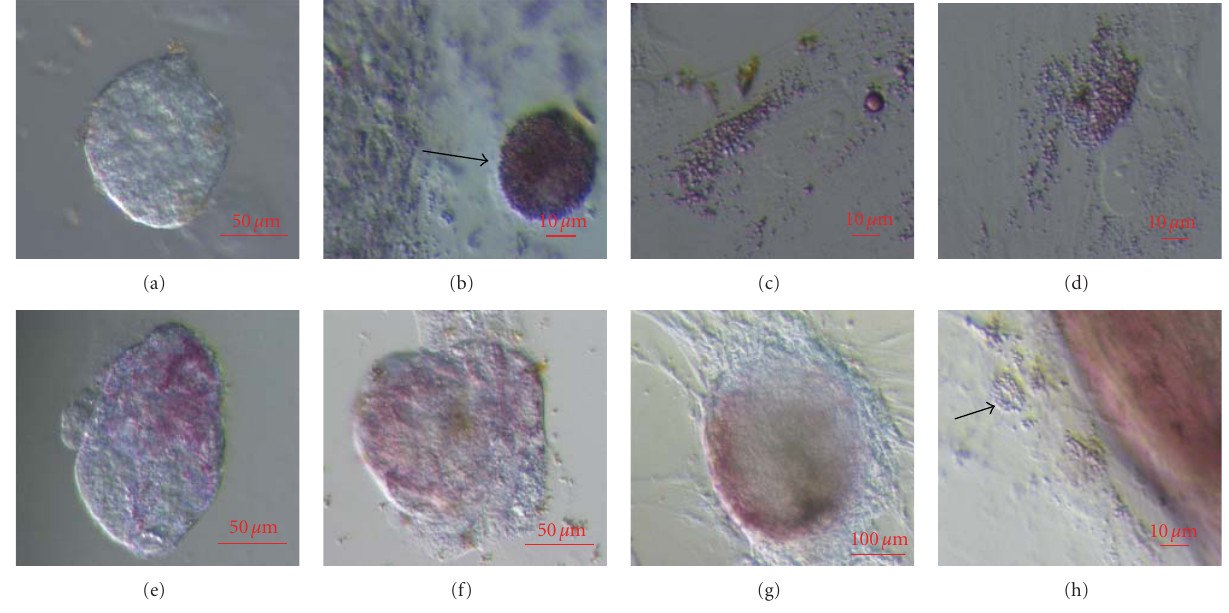
Figure 7: Alkaline phosphatase staining of cells and cell clusters during the culture of cells scraped from the ovarian surface epithelium. (a) Nonstained cell cluster (magnification 40-times). (b) Positively stained oocyte-like cell (arrow) (magnification 200-times). (c, d) Positively stained small round cells with diameters of 2 to 4 μ m proliferating in a cell culture (magnification 200-times). (e, f) Positively stained cell clusters (magnification 40-times). (g) Positively stained cell cluster developing on the layer of autologous ovarian fibroblasts (magnification 100-times). (h) Small round cells (arrow) with diameters of 2 to 4 μ m proliferating in the near surroundings (magnification 200-times). (inverted microscope, Ho ff man illumination.)